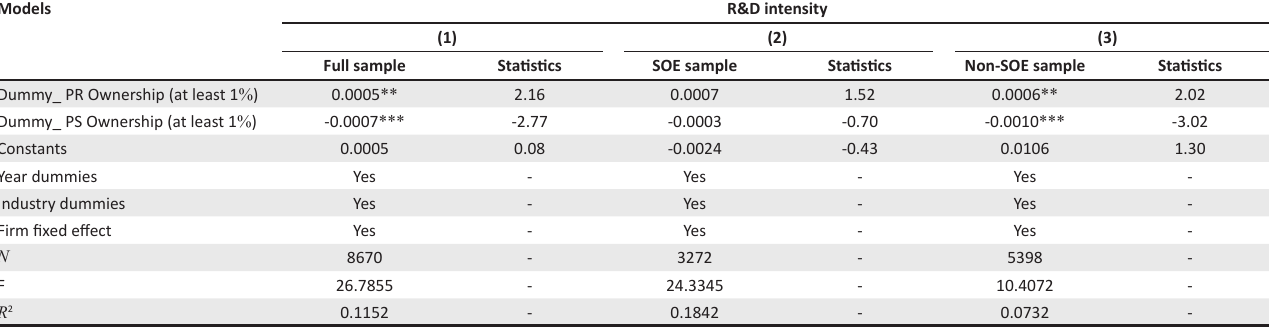
TABLE 6: The influence of institution investors (dummy variables) on research and development intensity.